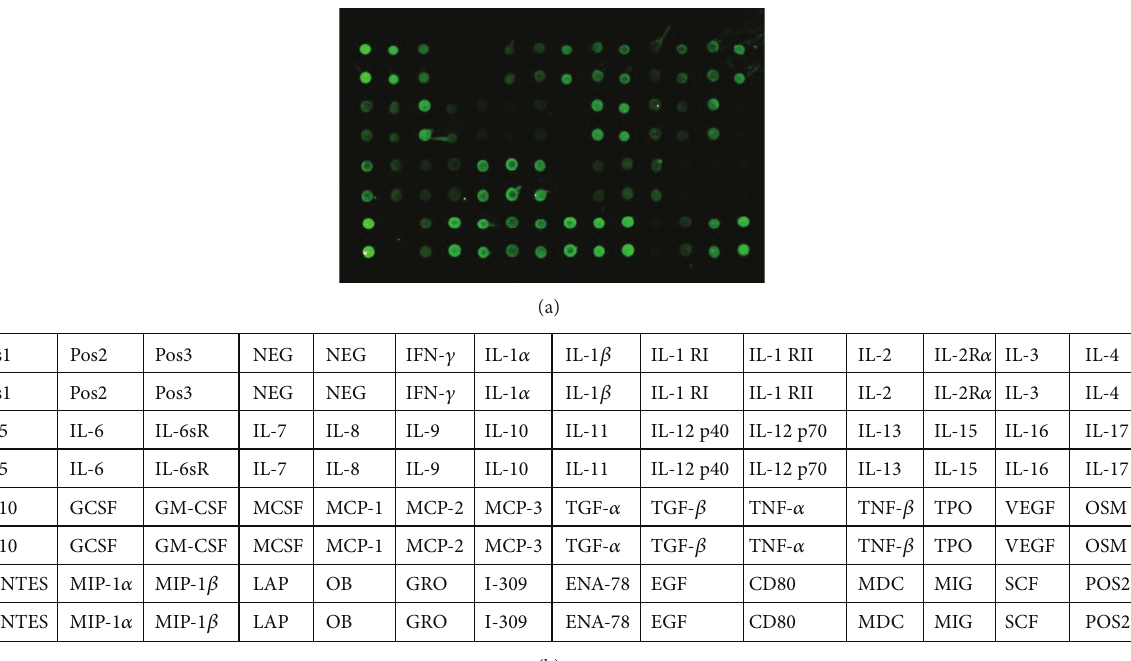
Figure 1: The cytokine profiles in sera of the subjects. (a) The comparative level of cytokines in sera of workers exposed to low dose irradiation were measured using Human G-Series Custom Array (RayBiotech, Inc., Norcross, USA) according to the manufacturer’s suggestion. (b) The names of cytokines were list in the box.